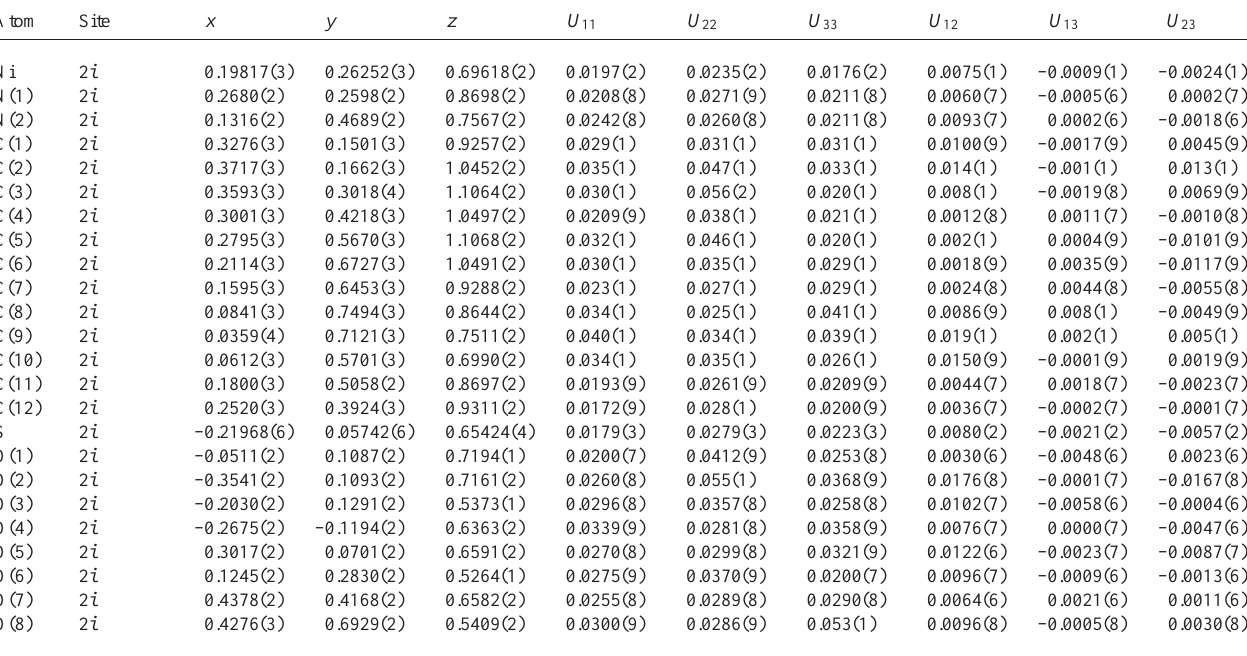
Table 3. Atomic coordinates and displacement parameters (in Å 2 )